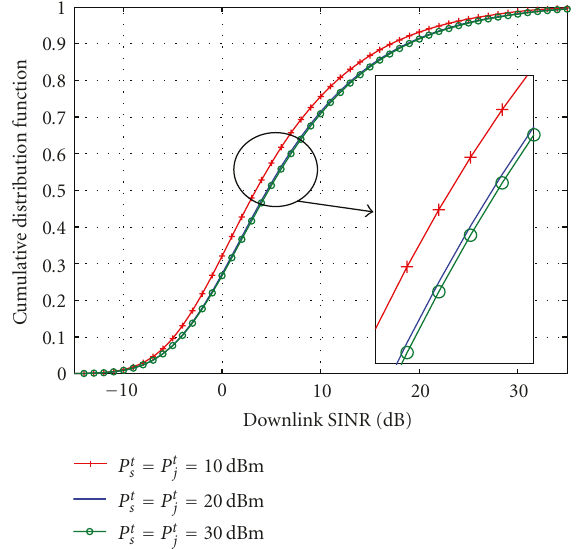
Figure 9: E ff ect of BS transmission power and background noise on CDF of SINR (FW method, σ X